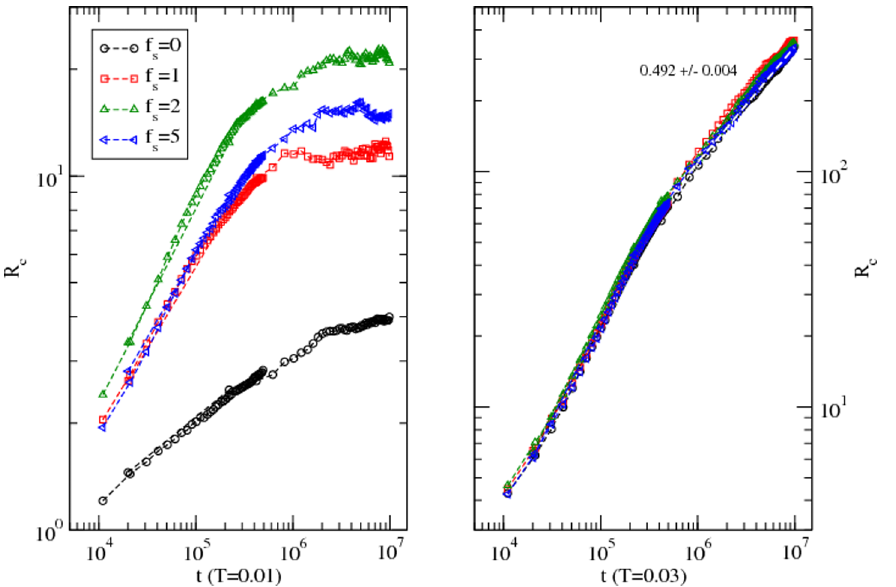
Figure 4. Variation of the root mean square displacement of the center of mass of the protein with the time step at a low ( T=0.010 ) and a high ( T=0.030 ) temperature in solvent with different interaction strengths ( f s =0–5 ). Simulations are performed on a 64 3 lattice with 100 independent samples at each temperature and solvent strength.